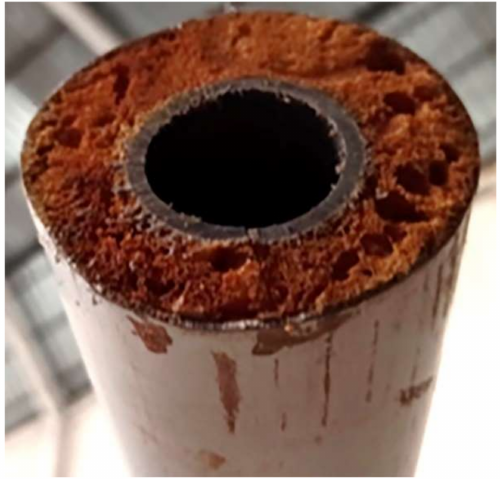
Figure 3. Detail of the tube of protection.